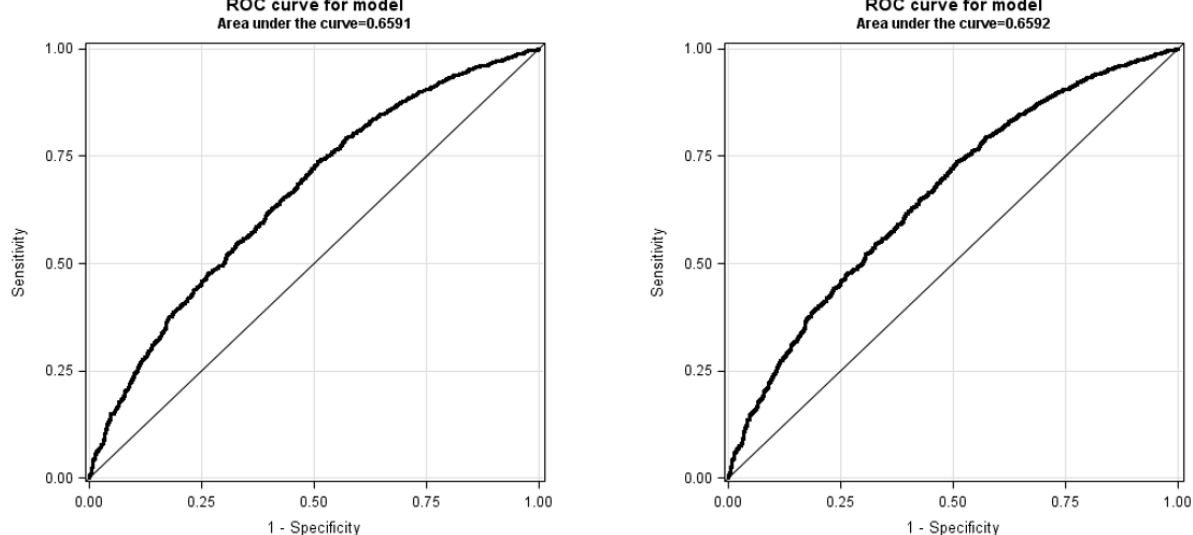
Figure 3. Comparison of receiver operating characteristic curves between distributed logistic regression (left) and pooled individual-level logistic regression (right). To offer better privacy-protecting, individual-level predicted values were summarized in bins of 6 and transferred to the analysis center for aggregation in the distributed logistic regression analysis. The size of the bin is user-specified. ROC: receiver operating